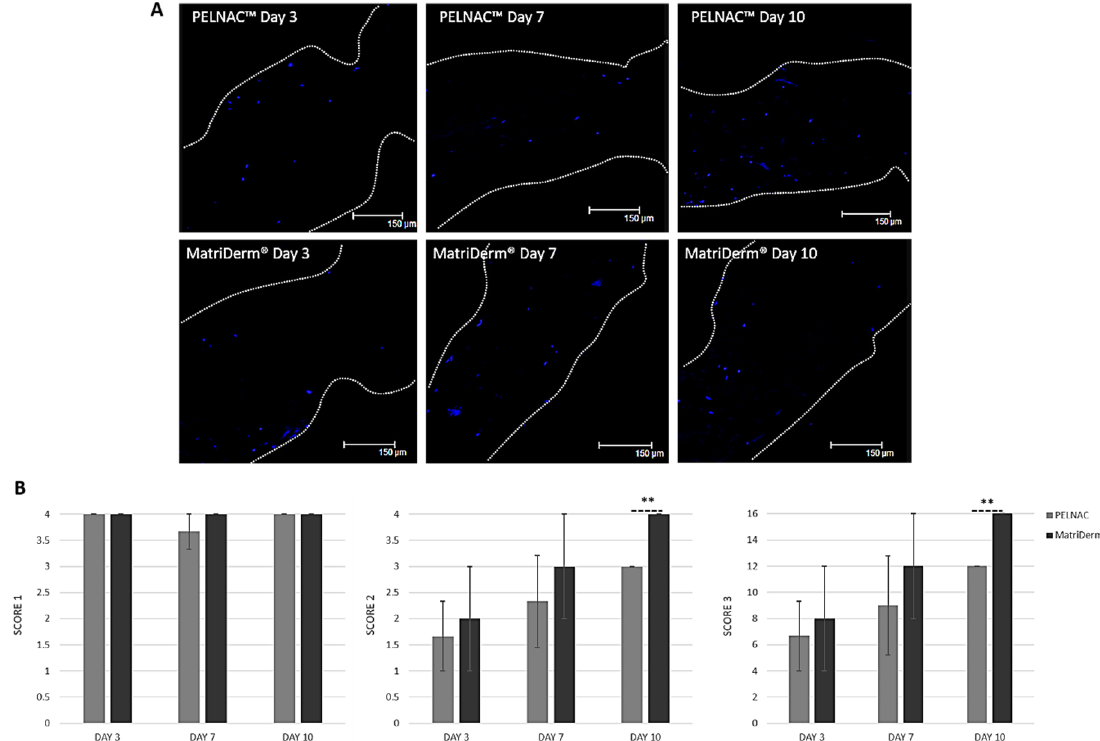
Figure 8. Cell infiltration into the scaffolds. ( A ) Representative confocal microscopy images of cells in scaffolds (white dotted line indicates edges of scaffold and blue fluoresce is indicative of cell nuclei). ( B ) Quantification of cell infiltration into the scaffolds: score 1 denotes distance migrated by the cells, score 2 denotes cell density and score 3 = score 1 × score 2. Results show average ± standard error of mean ( n = 3). ** p < 0.001.